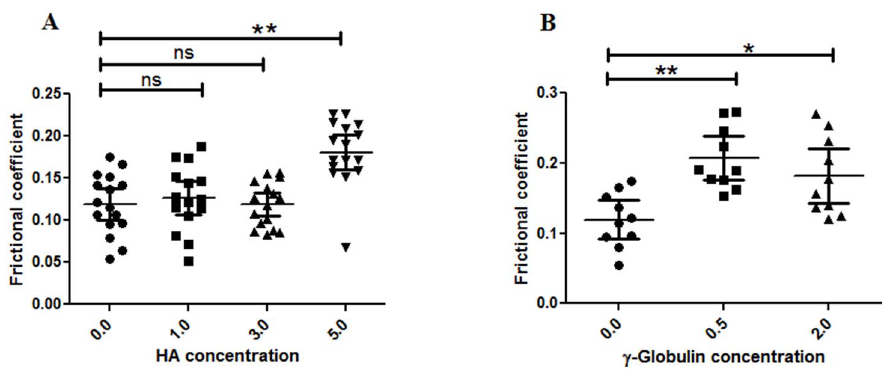
Figure 7. AFM measured frictional coefficient of normal human articular cartilage in range of (A) HA (no of observation 5 16) and (B) c –globulin (no of observation 5 10) concentration. Increase in HA concentrations shows no significant changes in frictional coefficient of normal articular cartilage samples, while c –globulin depicts concentration based effect. The frictional coefficient values are from measurements at different locations on two samples of normal human cartilage from a single femoral head. Vertical bars represent 95% of confidence interval. *P , 0.01, **P , 0.0001, and ns (no significance).